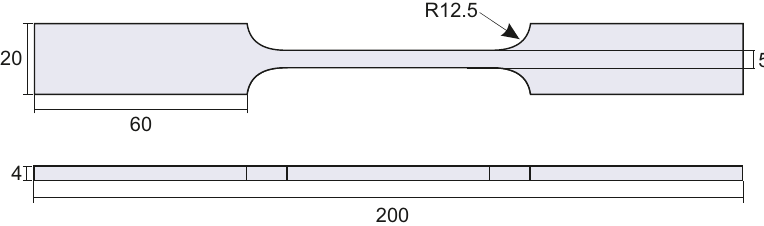
Figure 2. Geometry of the tensile specimen (all dimensions in